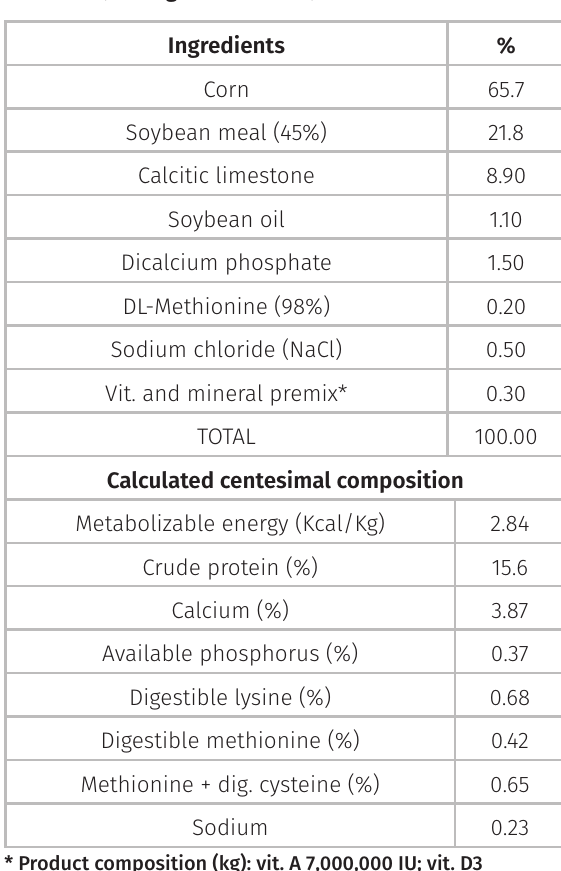
Table I. Ingredients and calculated chemical composition of the diet base and reference to be used in the Experiment I of digestibility, following recommendations of the Brazilian table of poultry nutrition (Rostagno et al.